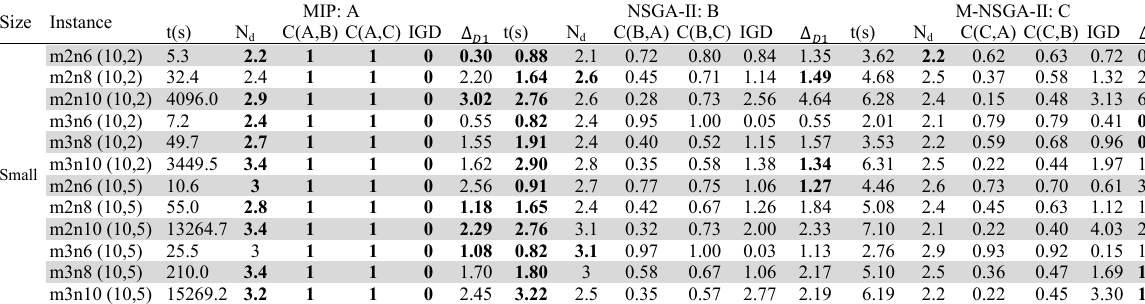
Performance results for different algorithms (small-scale problem instances) MIP: A Size Instance m2n6 (10,2)